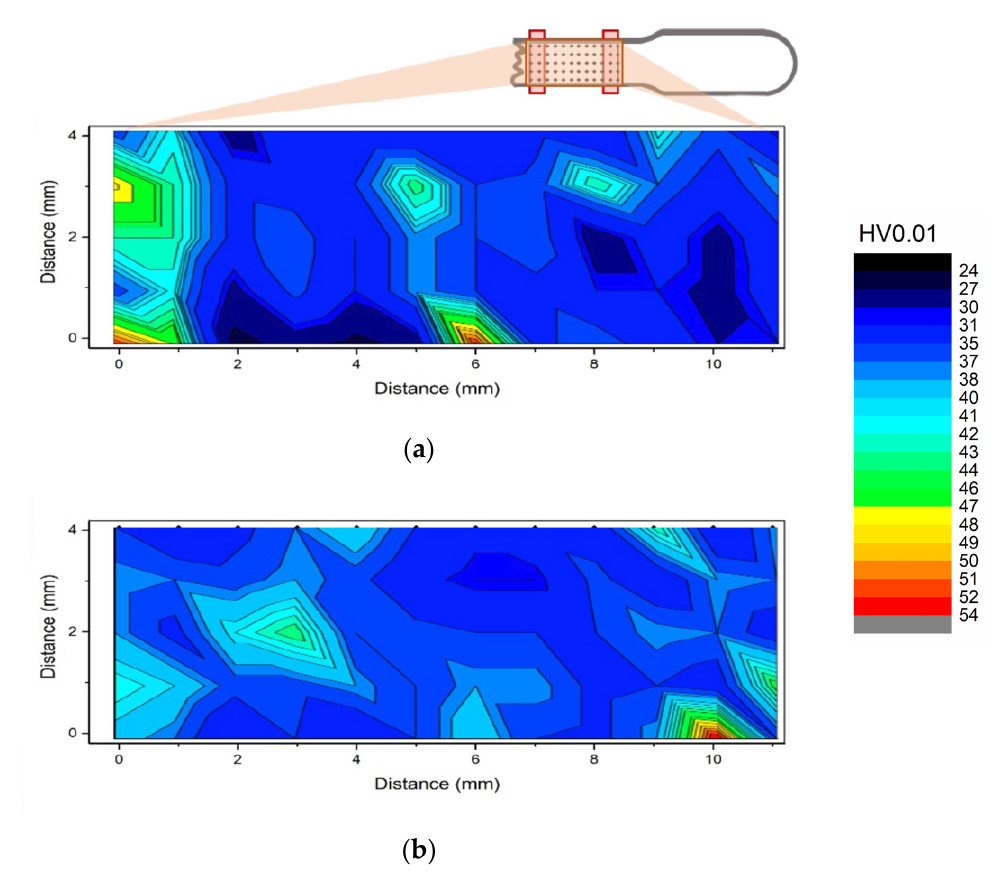
Figure 10 . Hardness distribution maps (HV 0.01) of ( a ) Al and ( b ) Al/CNT of fractured tensile test specimens.